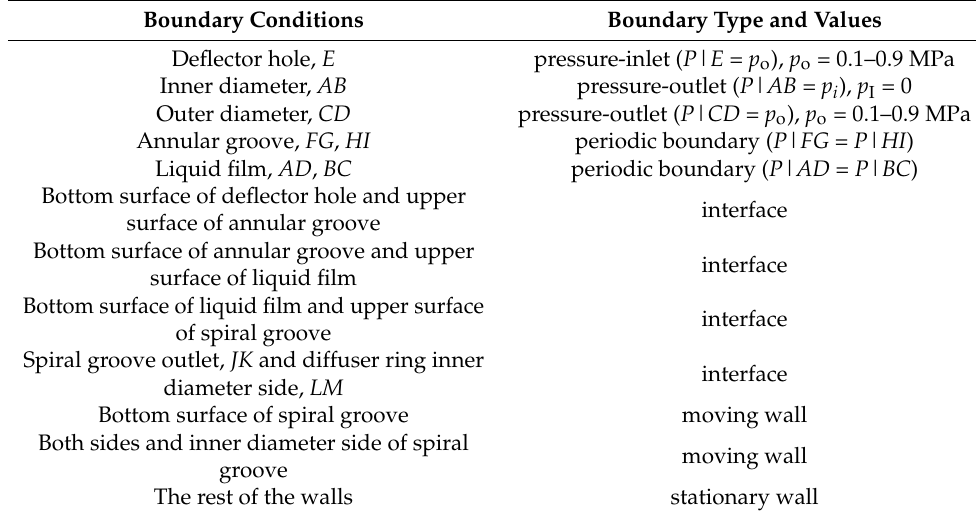
Table 1. Boundary condition